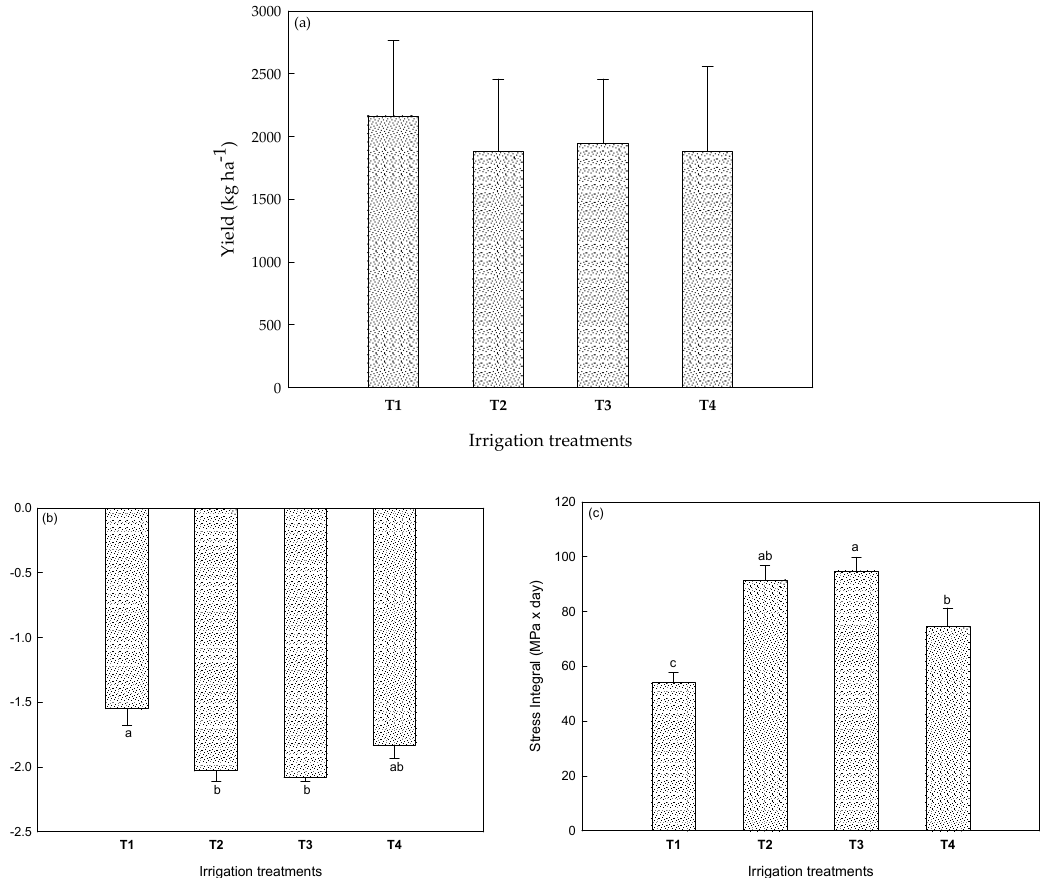
Figure 1. Almond yield ( a ), minimum stem water potential ( b ), and water stress integral ( c ) for each treatment. Bars with the same letter were not significantly different (( a ) p < 0.001; ( b ) p < 0.01; ( c ) p < 0.001), according to Tukey’s least significant difference test .